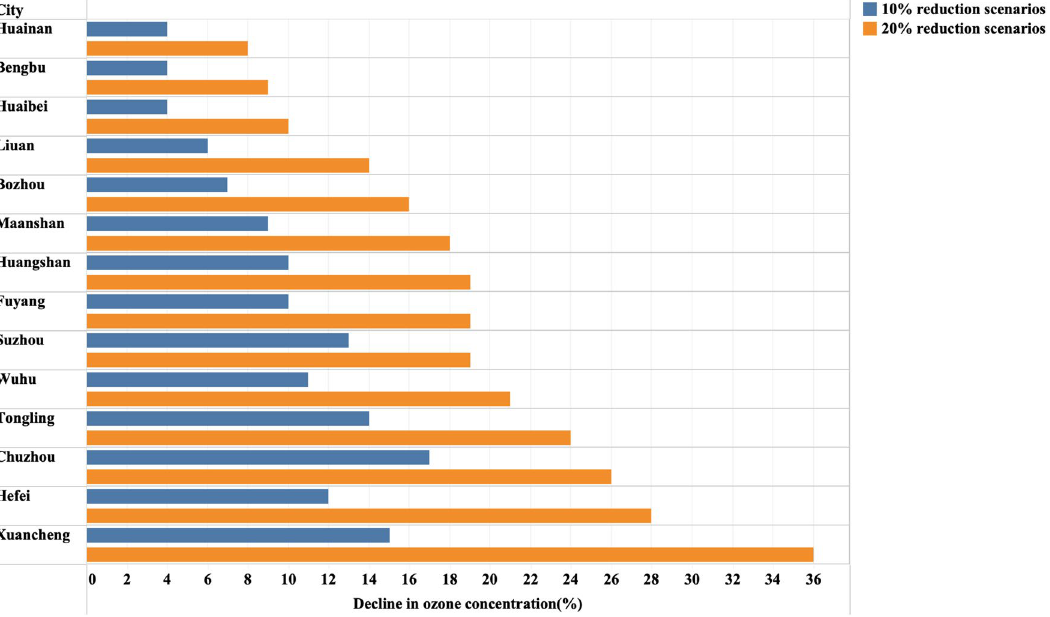
Fig. 8 The effect of ozone pollution control under the scenarios of 10% and 20% reduction in electricity consumption for all VOC-electricity sensitive industries in